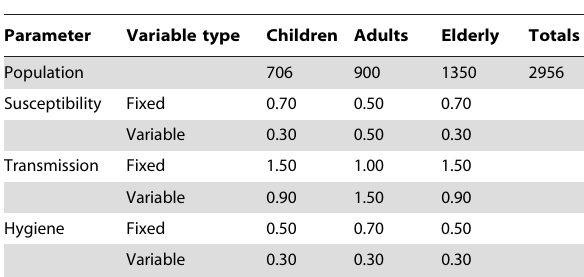
Table 2. The parameters used for the nuclear families.